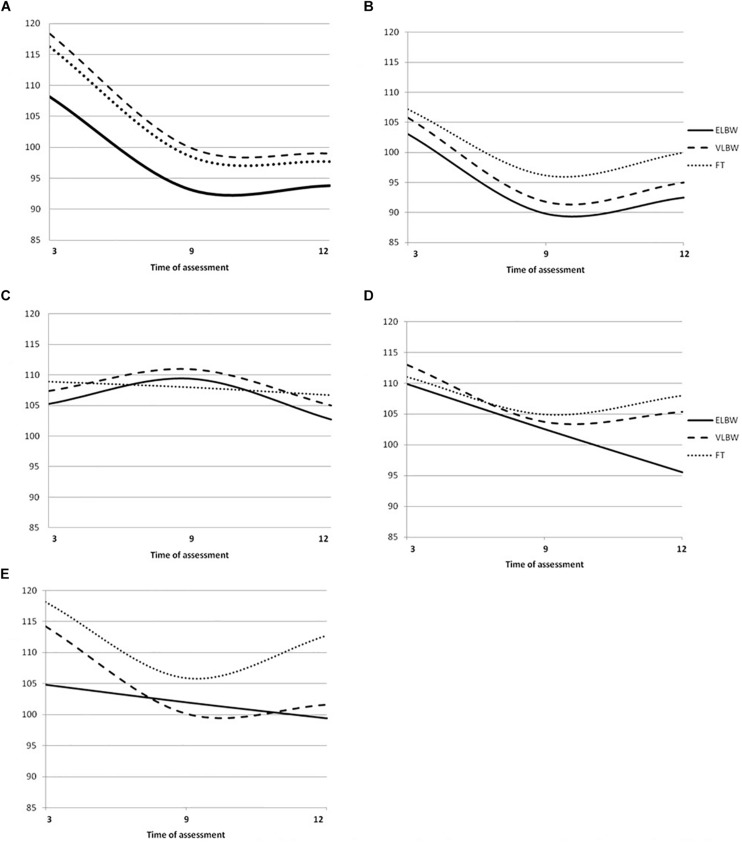
Griffiths Mental Development Scales quotient growth trajectories in ELBW. VLBW and FT infants. (A) Locomotor mean Quotients, (B) Ferscnal-Social mean Quotients, (C) Hearing and Language mean Quotients; (D) Eye-Hand Coordination mean Quotients; (E) Performance mean Quotients Continue line denotes ELBW group; dashed line VLBW group; dotted line FT group.